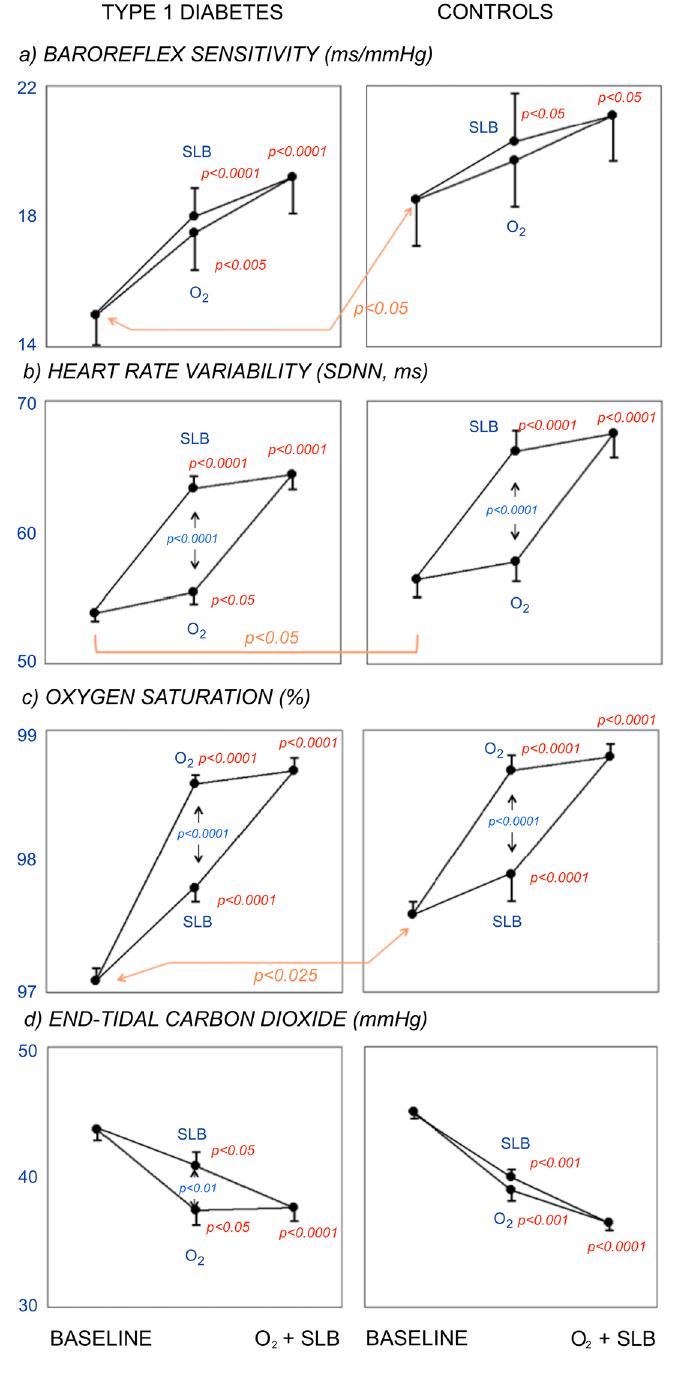
Figure 1. Effect of Slow Breathing (SLB) and Oxygen (O 2 ), alone (middle data of each panel) and combined (right data in each panel) on autonomic function: baroreflex sensitivity (panels a) and heart rate variability (standard deviation of RR intervals, SDNN, panels b), and blood gases: oxygen saturation (panels c) and end- tidal carbon dioxide (CO 2-et , panels d). Data from Type 1 diabetic (left panels) and control participants (right panels). Baseline: spontaneous breathing in room air. Within each panel, significances written in red refer to baseline, significances in blue refer to SLB vs O 2 . Note the additive effect of oxygen and slow breathing in all autonomic and respiratory